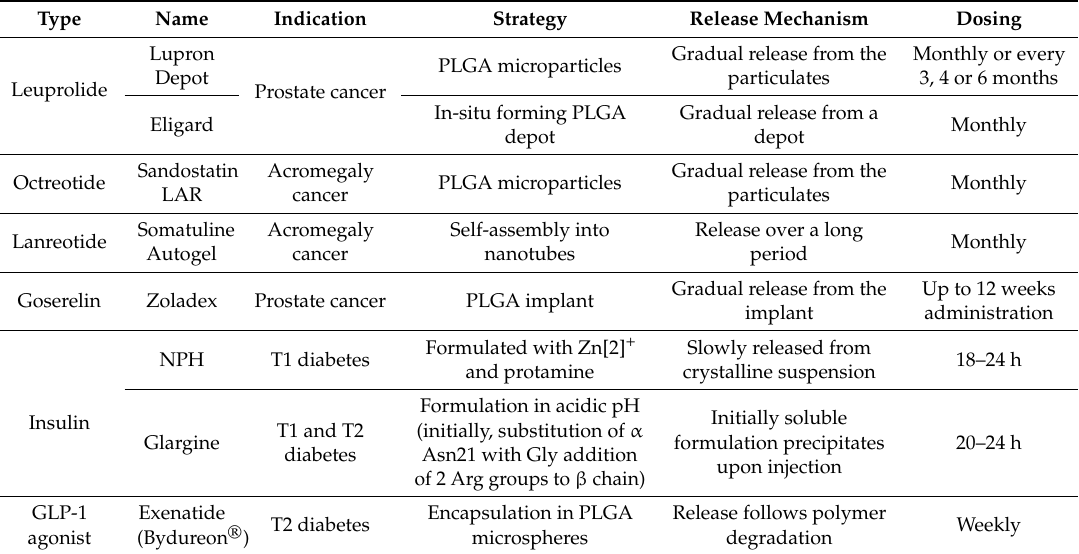
Table 2. Clinically approved long-acting biotherapeutics administered via the SC